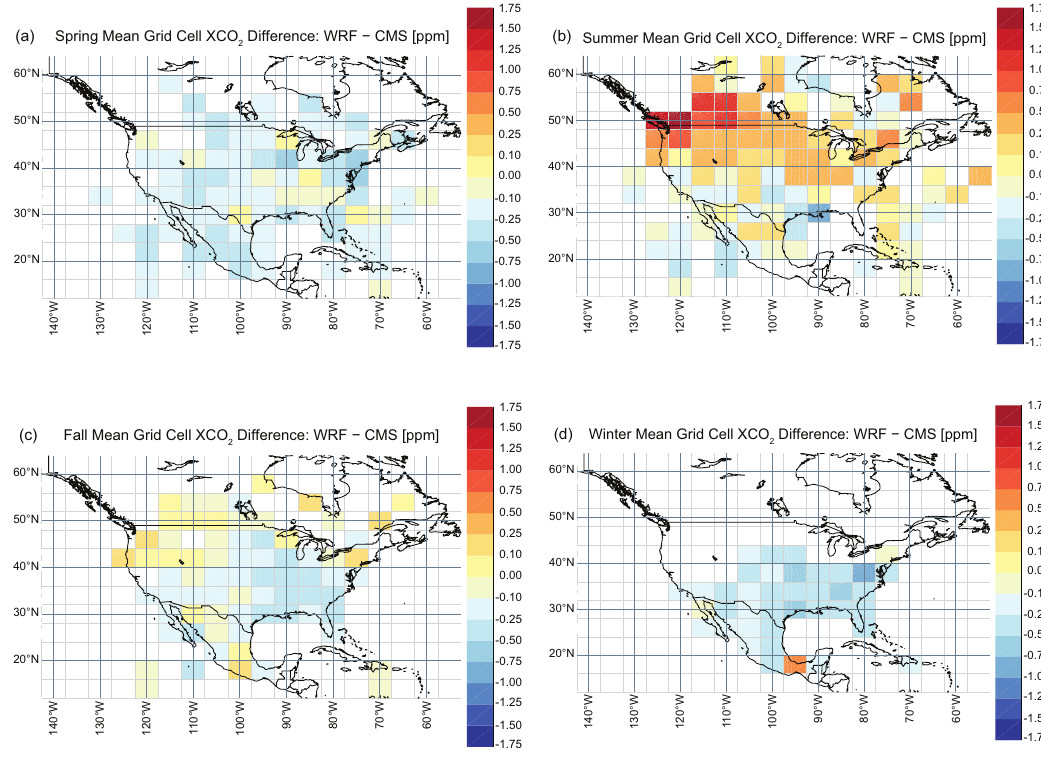
Figure 5. Seasonal mean spatial differences in WRF and CMS simulated XCO 2 aggregated to the GEOS-Chem CMS-Flux grid (light gray lines) for ( a ) spring, ( b ) summer, ( c ) fall and ( d ) winter. Grid cells with no shading have fewer than 10 GOSAT soundings for the season